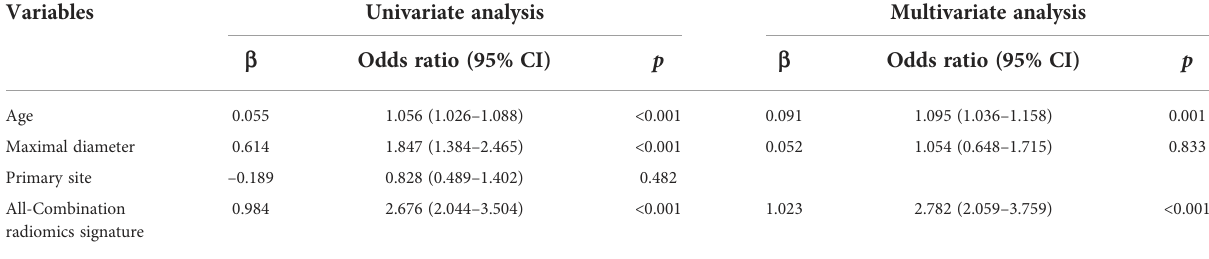
TABLE 4 Risk factors associated with malignancy of breast lesions using univariate and multivariate